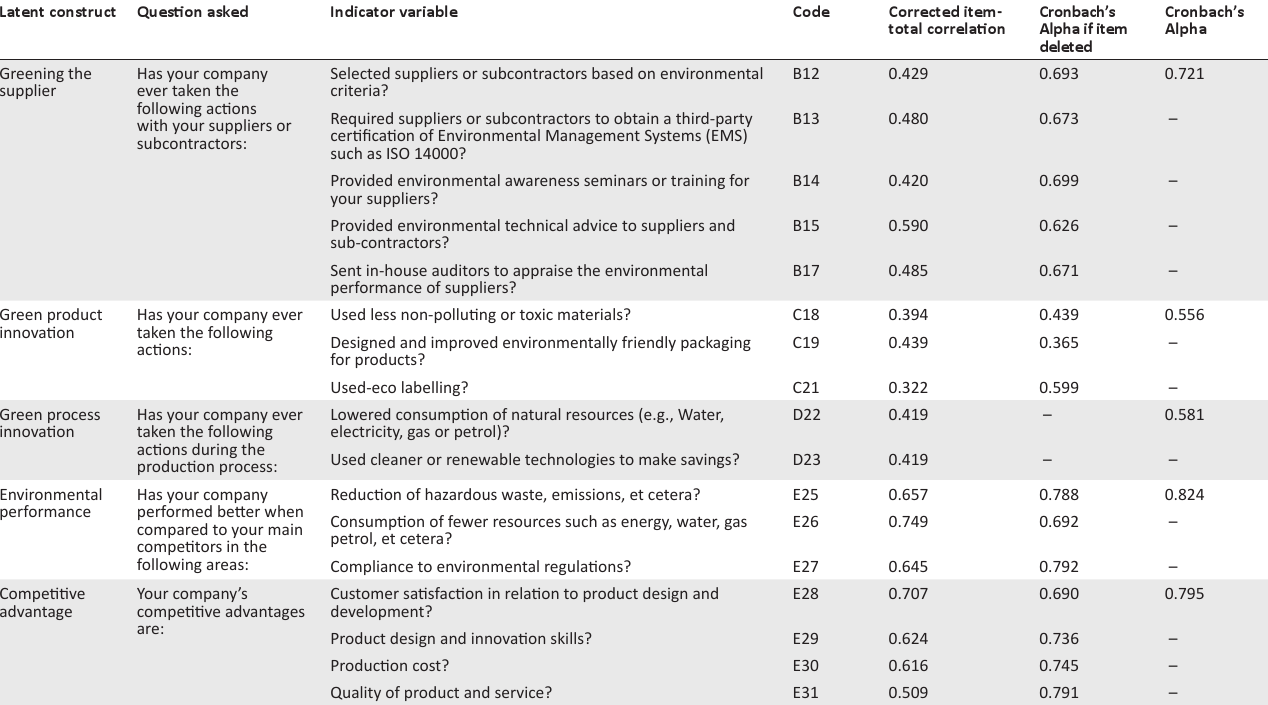
TABLE 2: Reliability